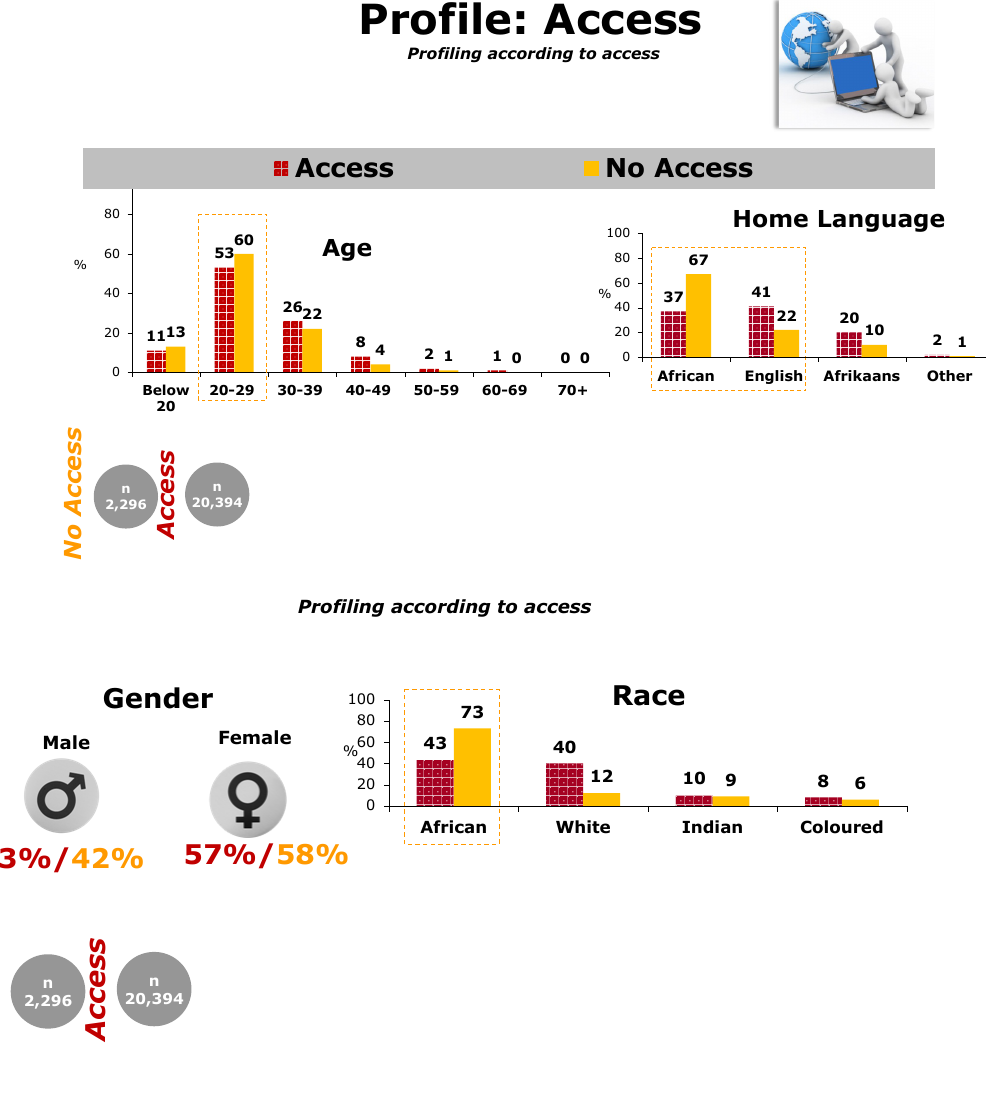
Figure 2. Profile according to access: